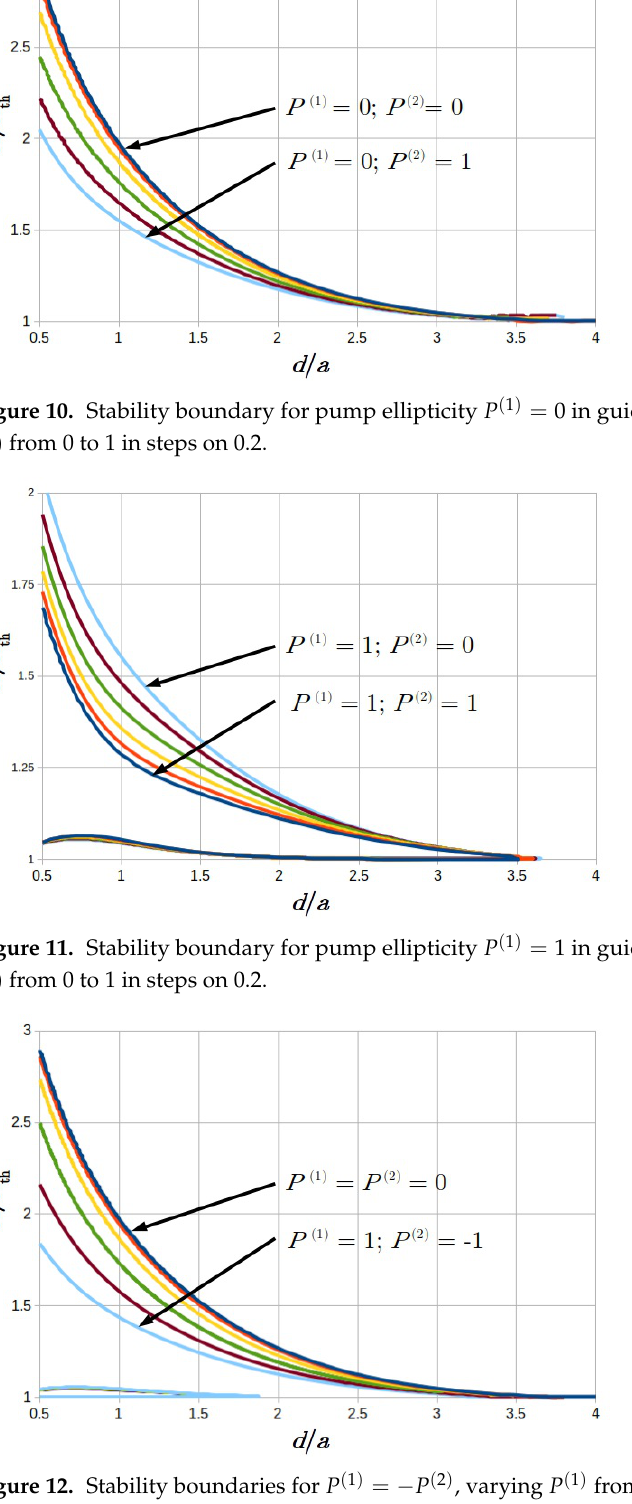
Figure 12. Stability boundaries for P ( 1 ) = − P ( 2 ) , varying P ( 1 ) from from 0 to 1 in steps on